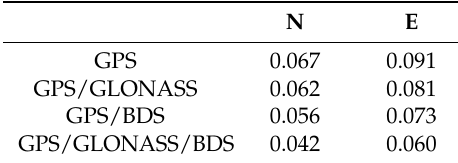
Table 4. STDs of the positioning errors for the four processing cases (unit: